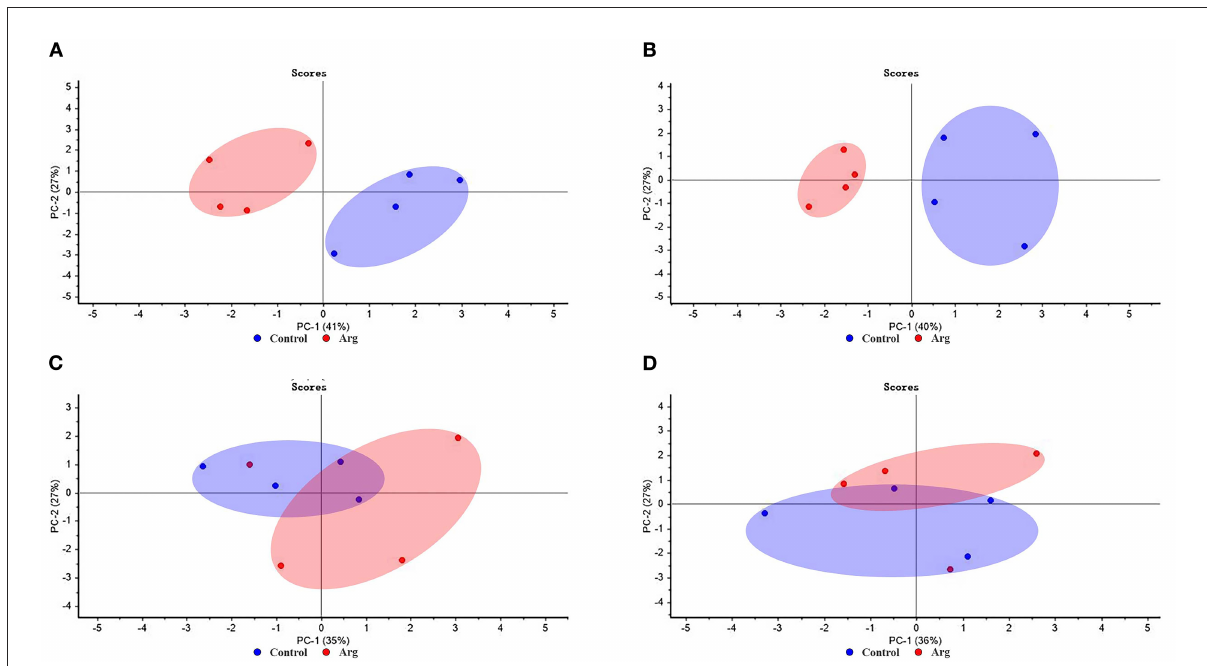
FIGURE4 Score plot of principal component analysis (PCA) for breast muscle characteristics and gene expression of muscle development from the two groups in slow-growing chickens. (A) Day of hatching; (B) day 21; (C) day 42; (D) day 63. Control, non-injected group; Arg, 1% L-arginine-injected